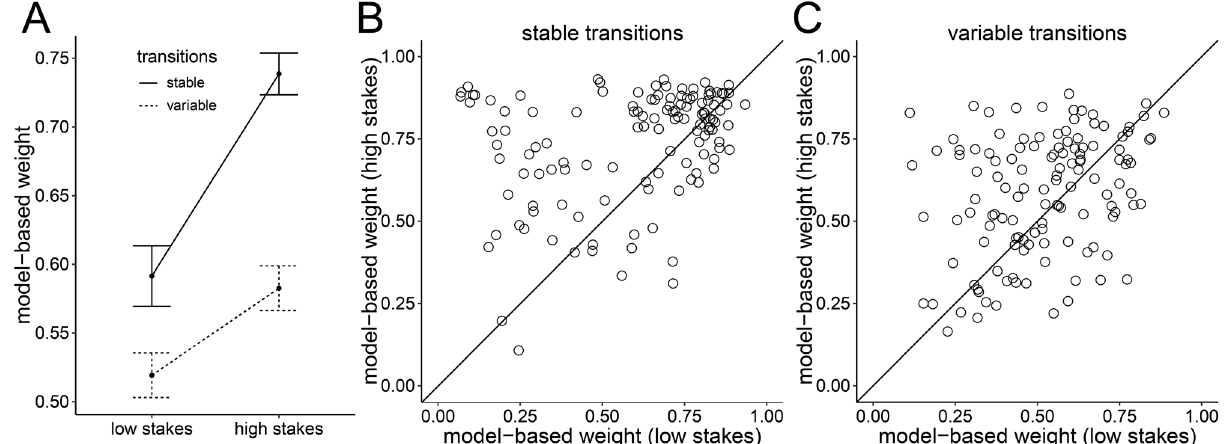
Figure 2. Metacontrol of decision making in Study 1. ( A ) Mean model-based weights. Error bars represent standard error of the mean. ( B , C ) Individual differences in model-based weights. Plots show model-based weights in high-stakes trials (y-axis) against model-based weights in low-stakes trials (x-axis) for stable- transitions blocks ( B ) and variable-transitions blocks ( C ). Points on the identity line represent individuals that showed no adaptation of model-based weights toward stakes conditions. Points above (below) the identity line represent individuals that showed higher (lower) model-based weights in high-stakes trials compared to low- stakes trials.